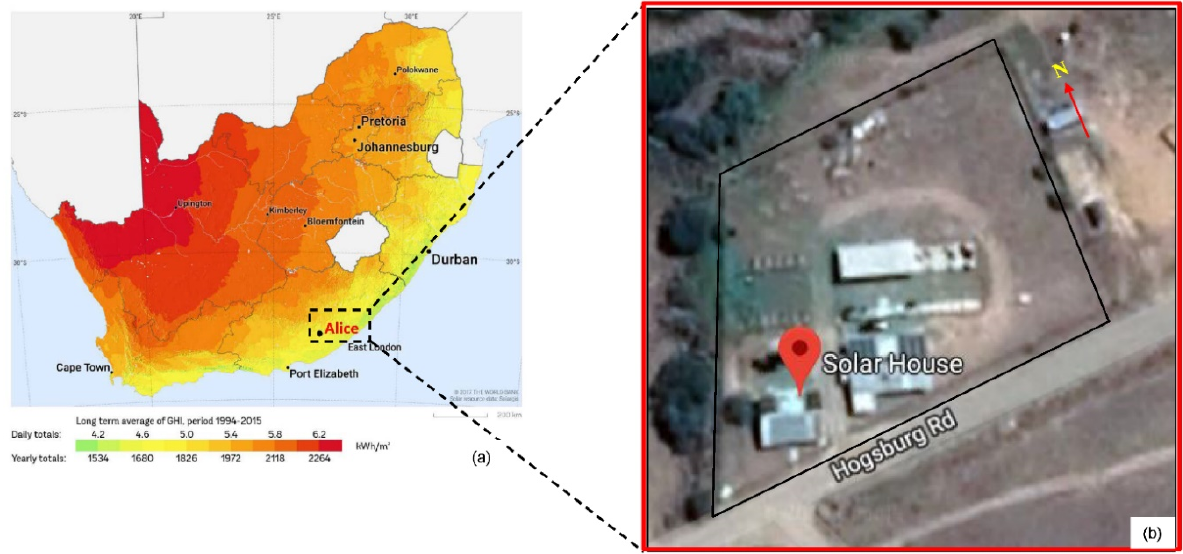
Figure 2. Map showing ( a ) daily average global horizontal irradiation for the study site from 1994–2015 [30] and ( b ) Google map of the study site (SolarWatt Park).